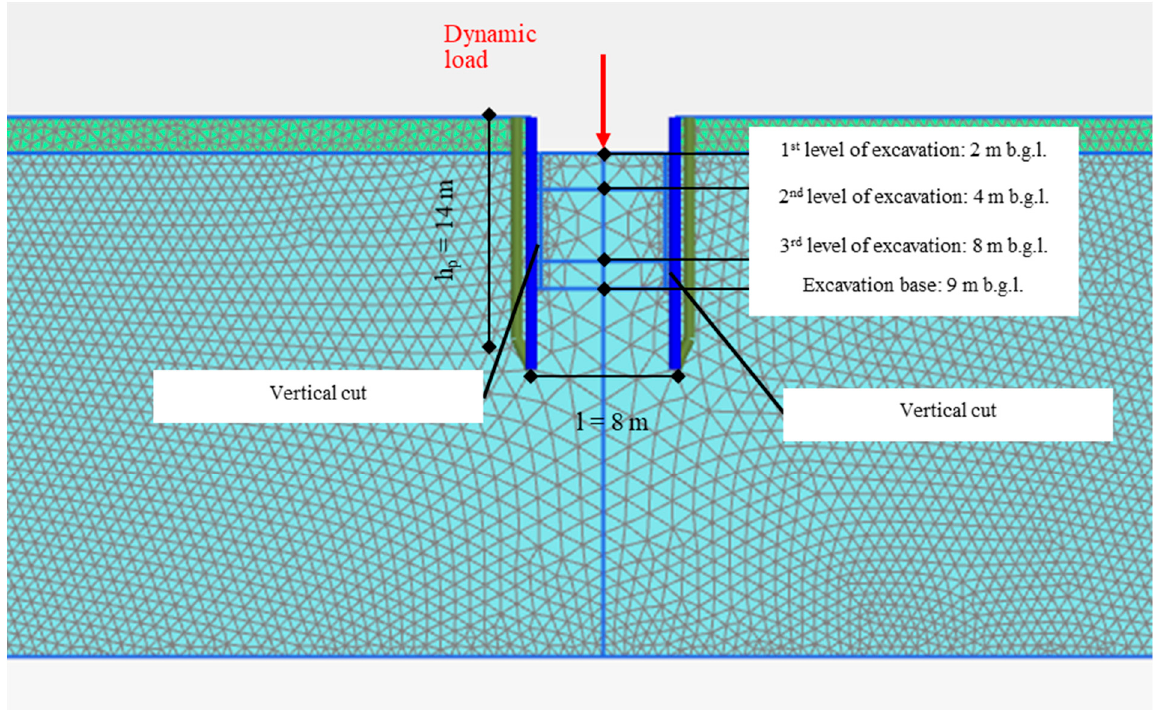
Figure 3. Details of the geotechnical numerical model. After the initialization of the geostatic stress state (performed through a standard K 0 -procedure), the installation of the diaphragm walls was simulated, followed by a first excavation phase during which the backfill material inside the trench was removed (first excavation level). Starting from a depth of 2 m below ground level (b.g.l.), three consecutive phases were simulated to progressively reach 4 m (second excavation level), 8 m (third excavation level), and 9 m b.g.l. (i.e., the excavation base). Each excavation stage in